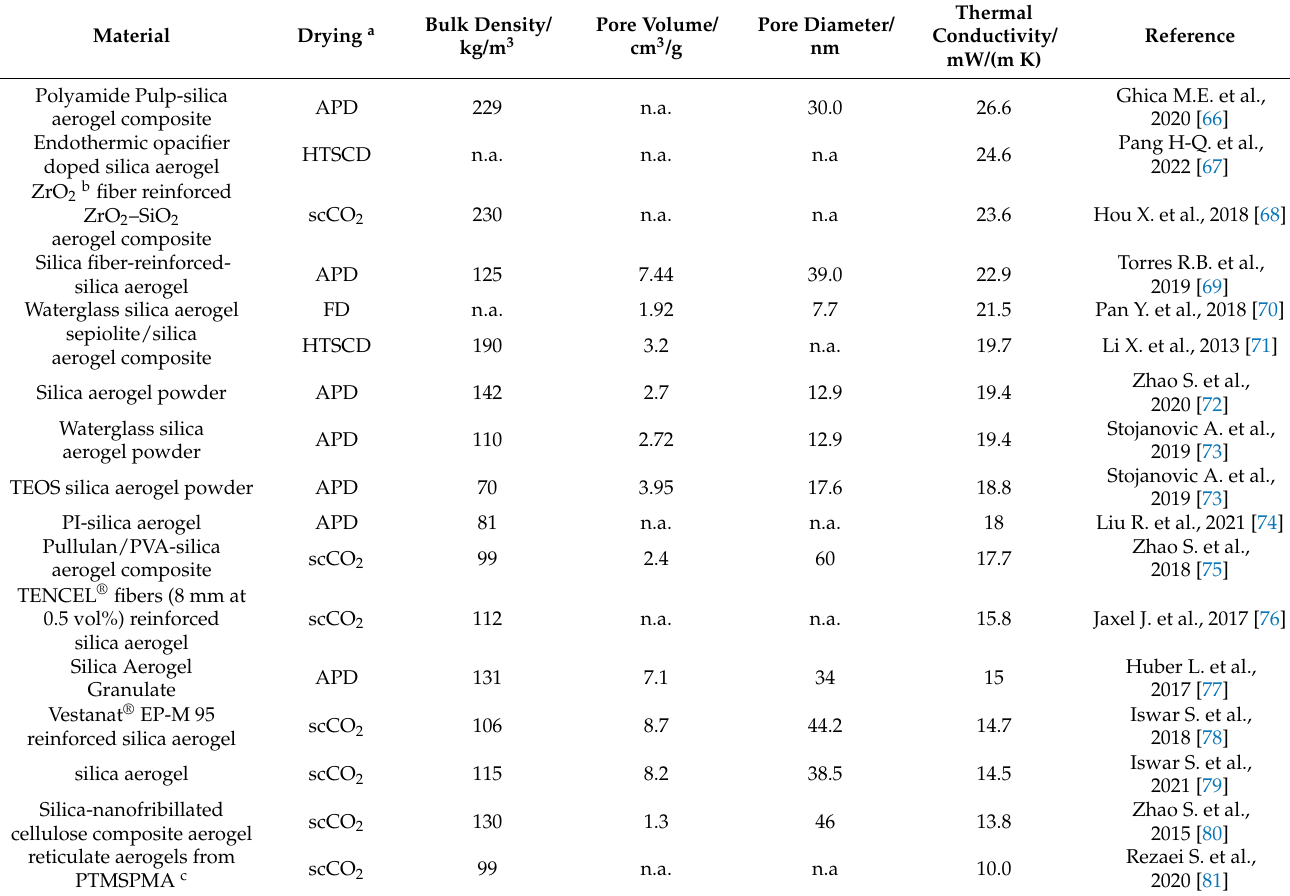
Table 4. Super insulating silica aerogels reported in the